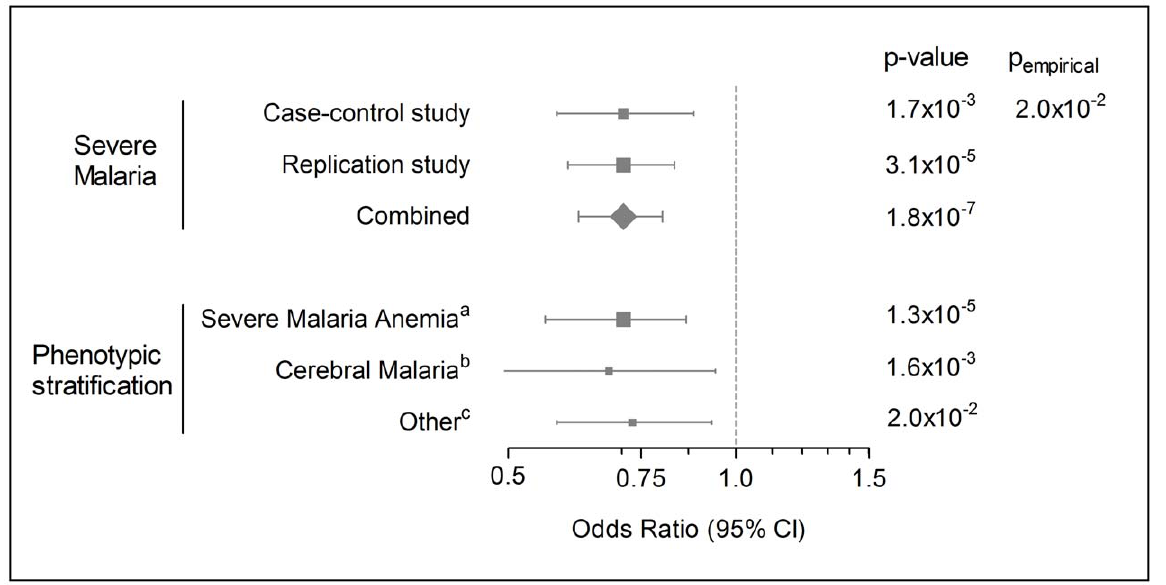
Figure 1. Forest plot of FAS c. 2 436.C . A association with severe malaria and sub-phenotypes. Odds ratios were calculated assuming the additive model of inheritance; symbol sizes represent relative numbers of individuals. a Combined result for severe malaria anemia with or without additional complications including cerebral malaria (n=1626). b Combined result for cerebral malaria with or without additional complications including severe anemia (n=569). c Severe malaria complications not including severe anemia or cerebral malaria (hyperlactatemia, 100%; prostration, 83%; hyperparasitemia, 56%; acidosis, 54%; respiratory distress, 27%, n=518).